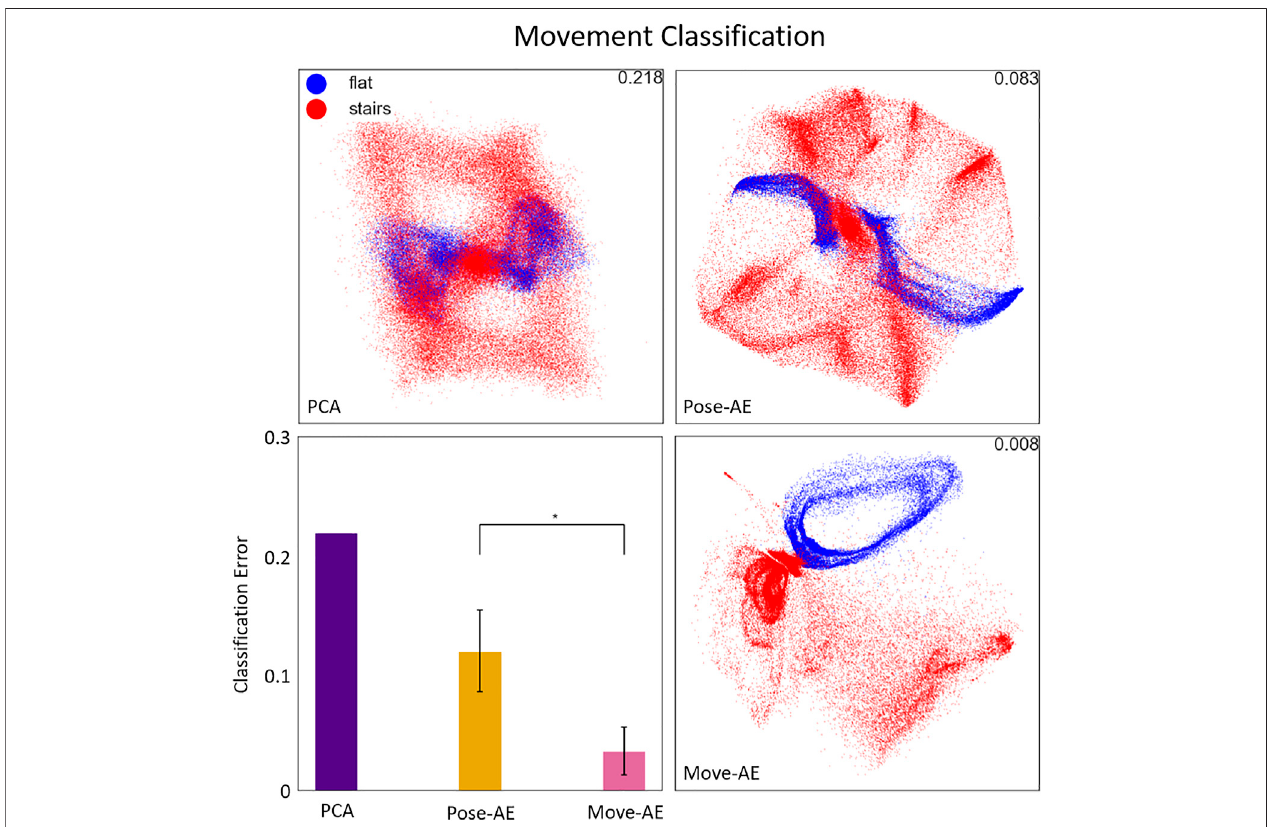
FIGURE 4 | The three panes display the best performing latent space of their respective method. The latent space is a visualization of the activations of the two codingunitsinthebottleneck,orthe fi rsttwoprincipalcomponents.Thebottom-leftpaneshowstheresultsofamovementclassi fi erSVMtrainedonthelatentspacesfor eachmethod.Errorbarsdenotethevaryingperformancefromeachof10runsforbothautoencoders.TheMove-AElatentspaceoutperformedPose-AEandPCAlatent spaces on classifying between fl at ground and stair walking. Recall that in the Move-AE latent space, each point represents an entire movement. Flat ground walking is embedded in a cyclical structure that is well separated from stair